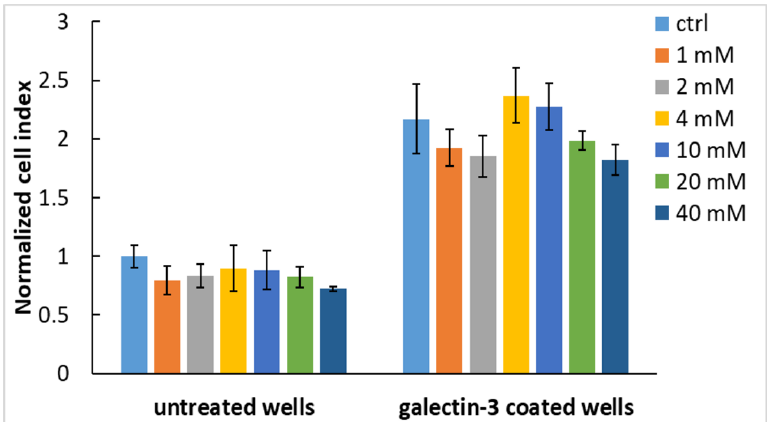
Figure 6. The effect of LacdiNAc on the initial adhesion of ADSCs one hour after seeding into untreated wells or wells preadsorbed with 1 μM Gal-3 and blocked with BSA. Before cell seeding, both groups of wells were preincubated with LacdiNAc in concentrations from 1 to 40 mM. Wells without LacdiNAc served as control samples (ctrl). Cell index values were normalized to the sample without Gal-3 adsorption and without LacdiNAc in the medium (ctrl - untreated wells). Mean ± SD from 3 wells. Holm-Sidak test, p ≤ 0.05. The cell samples were statistically compared either within the group of untreated wells or within the group of Gal-3-adsorbed wells. * Statistically significant difference in comparison with the control cells (ctrl).